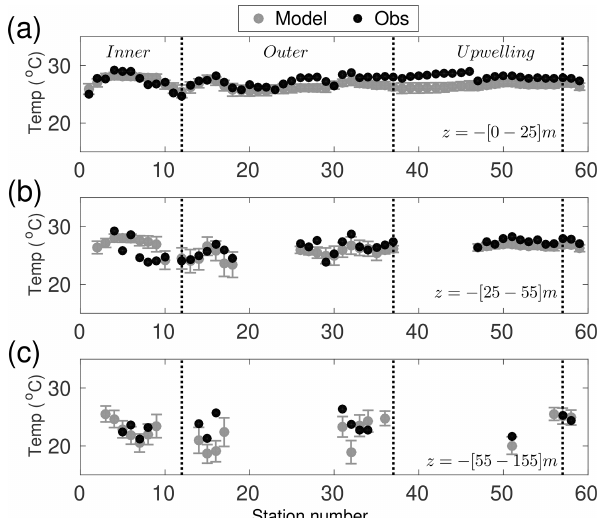
Figure 4. Comparison between in situ data and simulated temper- atures ( ◦ C). Temperature values correspond to each hydrographic station, averaged over three depths; (a) between the surface and 25m depth, (b) between 25 and 50m depth, and (c) between 55 and the deepest measured concentration ( z ∼ − 150m). Black dots cor- respond to the observed values and open grey circles to the simula- tion. Vertical grey lines are the temporal standard deviation of the simulated values, as these are temporally averaged over all Novem- bers from 2002 to 2010. Vertical black lines delimit the group of stations for the inner shelf, outer shelf, and upwelling